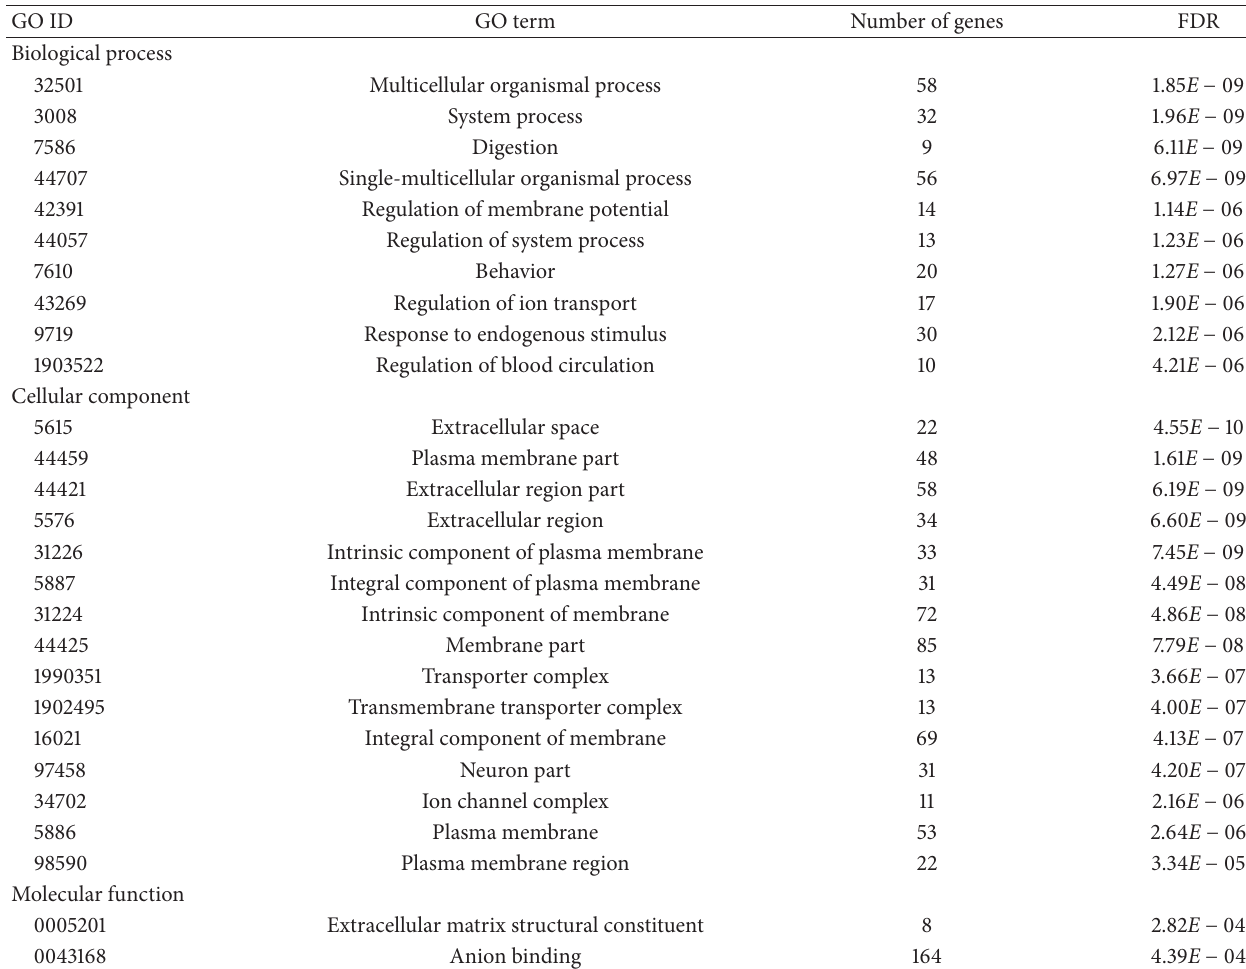
Figure 2: Heat map of top ten differentially expressed TFs in the dataset of TCGA stomach adenocarcinoma (STAD) gene expression by RNAseq. Sample type: green indicates the primary tumor of stomach adenocarcinoma ( 𝑛 = 384 ); grey indicates the normal lung tissue ( 𝑛 = 37 ). For each gene, red is upregulated and blue is downregulated in the corresponding sample. Table 3: Enriched GO terms of DEGs between gastric cancer and normal